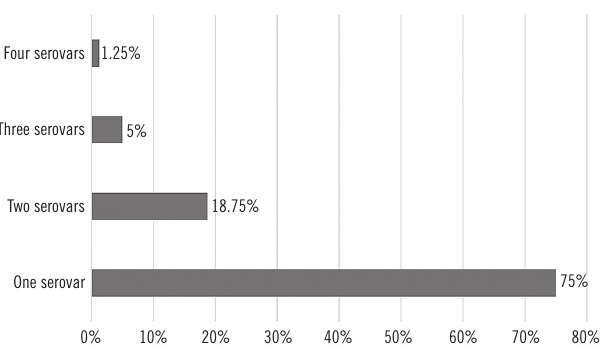
FigurE 1 − Percentage distribution of positivity for one, two, three or four serovars